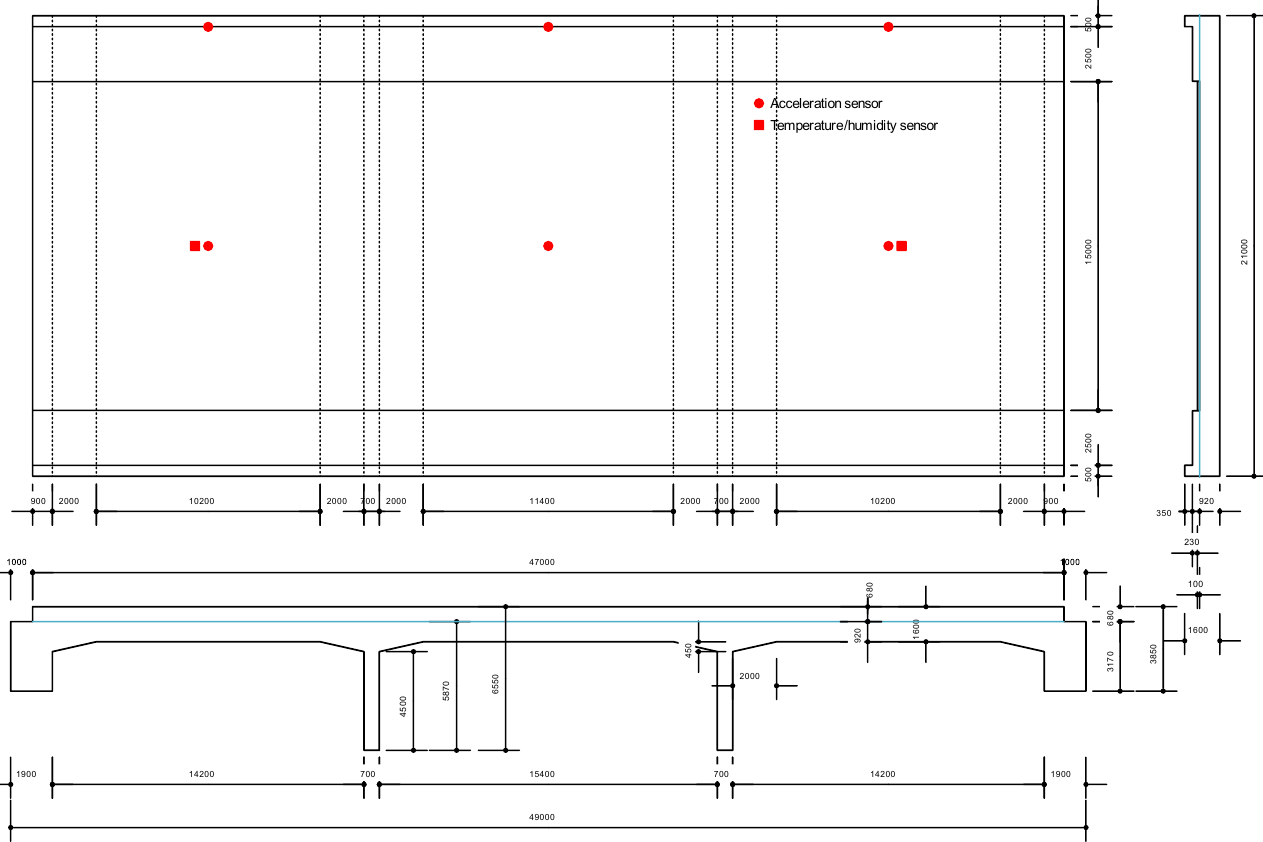
Figure 4. Shape and sensor layout of Gajwa Bridge.